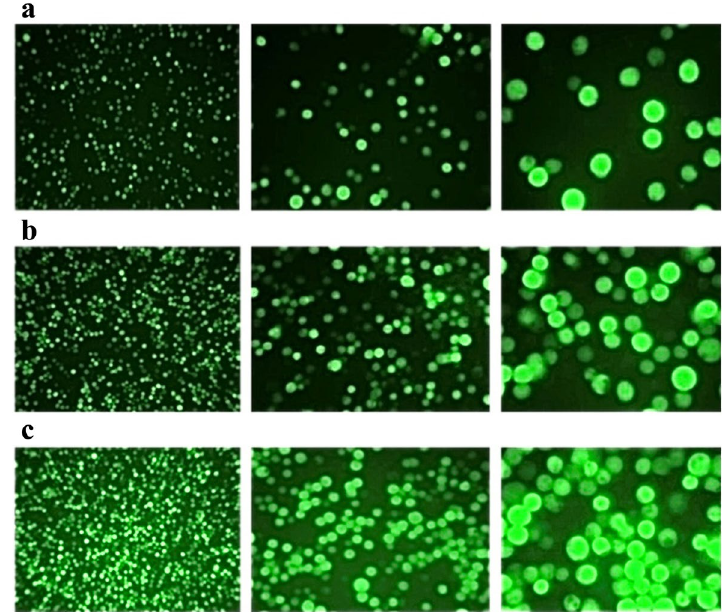
Fig. 1 The Sf9 insect cells infected by the recombinant baculoviruses expressing EGFP under the inverted fluorescent microscope by three magnifications of 10 , 20 , and 40 from left to right. a The cells transfected by recombinant bacmid shuttle vector (P0), b , c The cells infected by × × × P1and P2 baculoviral seeds, respectively ( P passage)